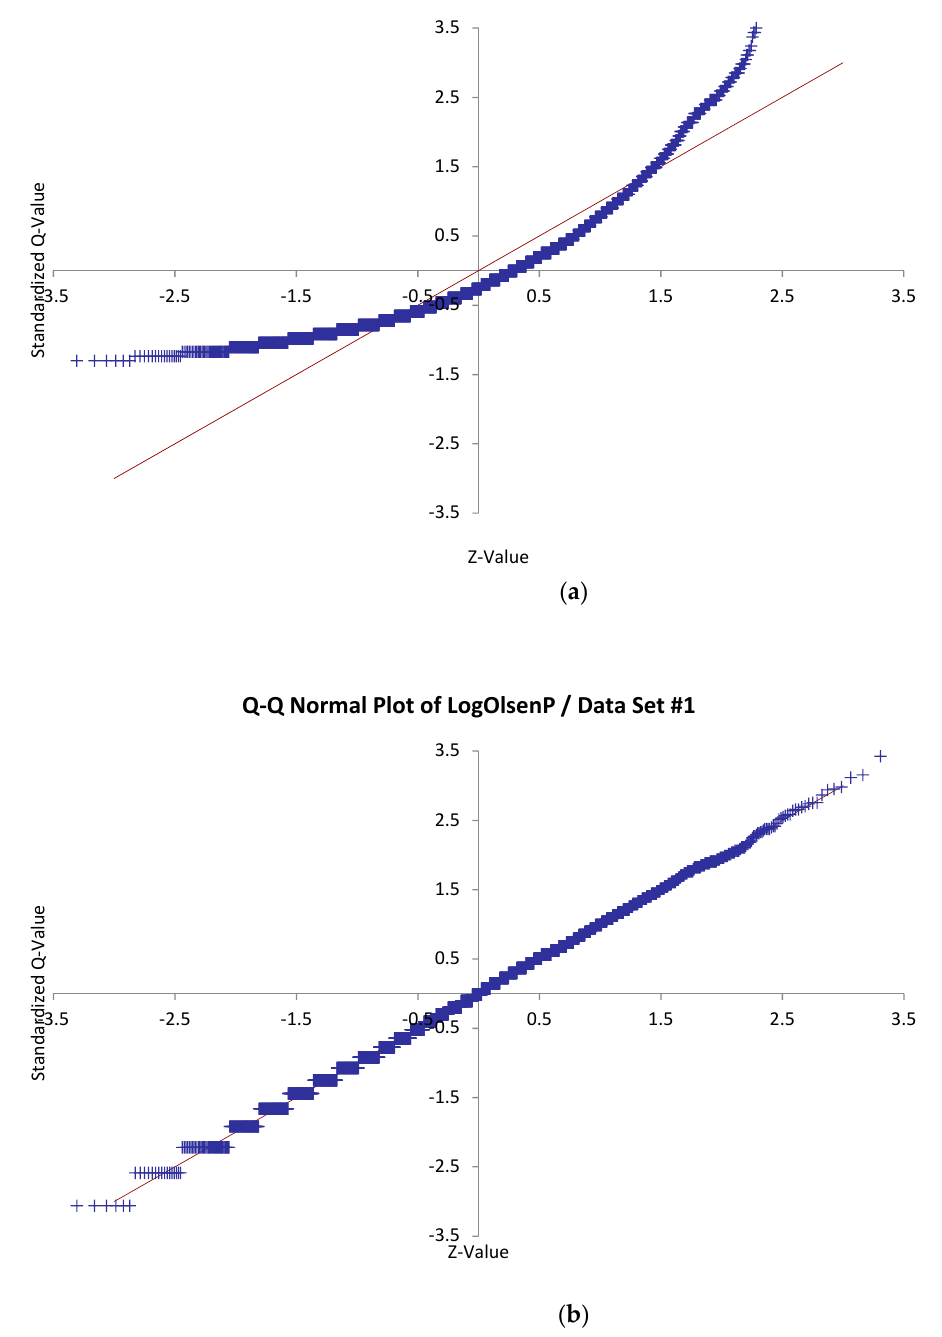
Figure 4. ( a ) shows a Q-Q Normality test for the raw Olsen P data with a Chi 2 distribution. ( b ) Shows that the Log 10 of the Olsen P of the data produces a normal distribution.